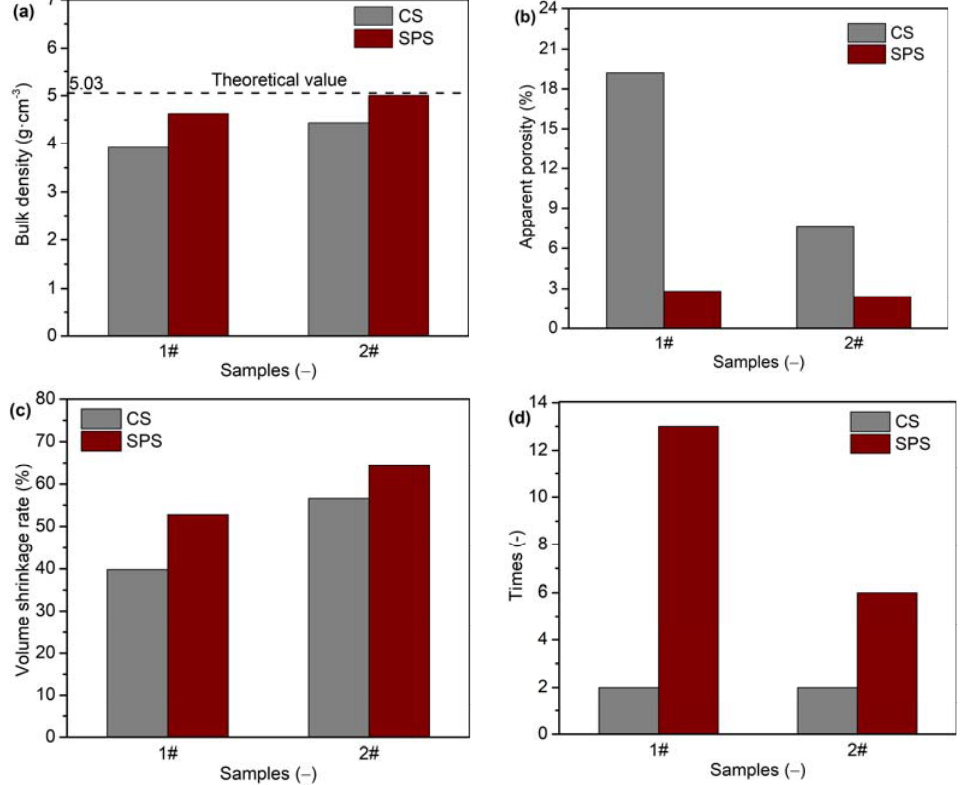
Figure 8. ( a ) Bulk densities, ( b ) apparent porosities, ( c ) volume shrinkage rates, and ( d ) number of thermal shock cycles of y tt ria ceramics.